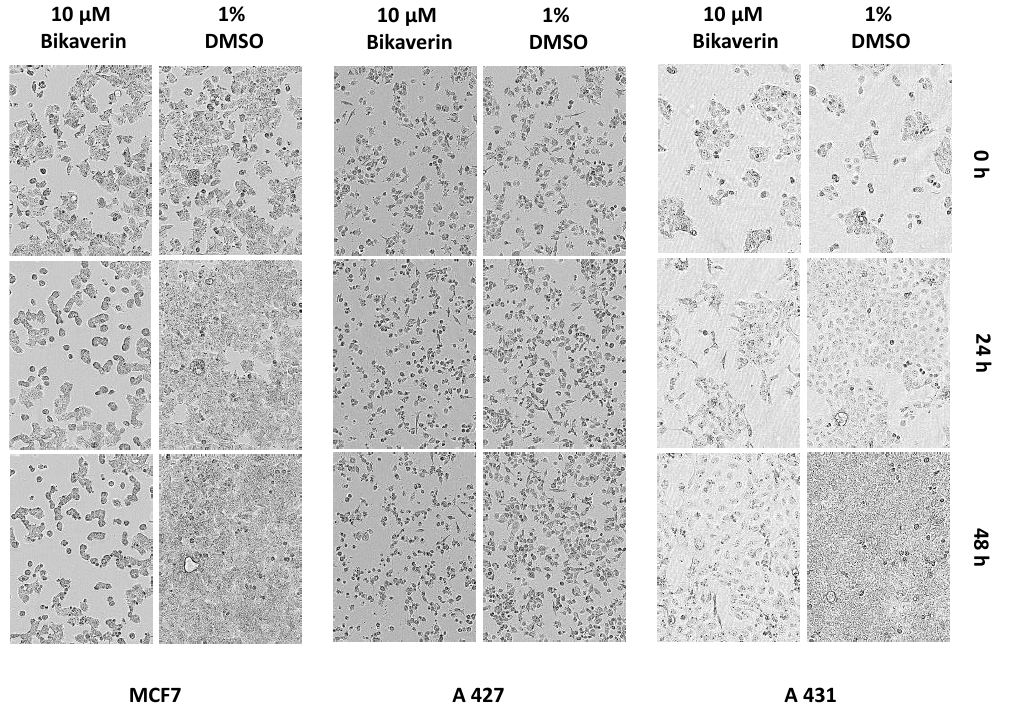
Figure 8. MCF7, A427 and A431 cells treated with 1% DMSO or with 10µM bikaverin for 0h, 24 h and 48 h and recorded by the IncuCyte ® live cell imager. The pictures were obtained using the IncuCyte ® live cell imager with a ten-fold lens.